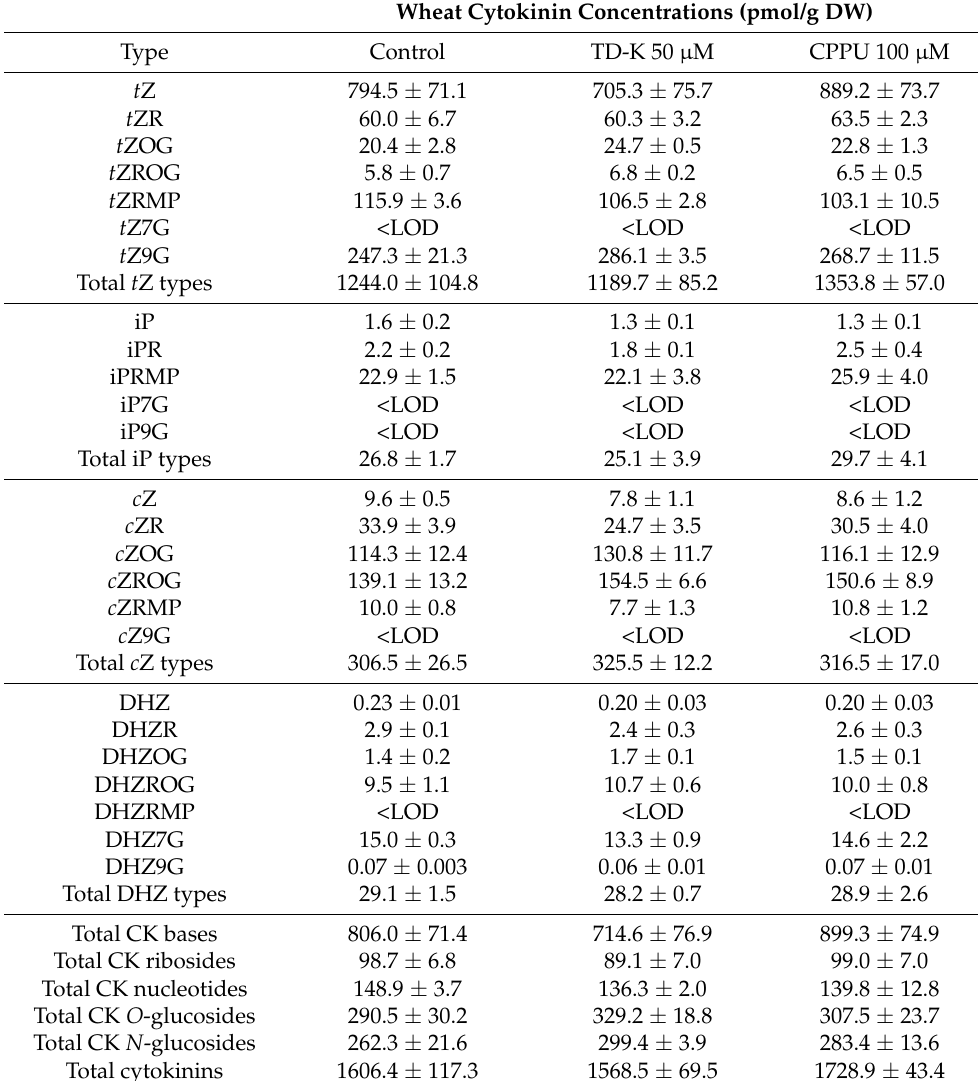
Table 2. LC–MS/MS analyses of the quantity of cytokinins in wheat (cultivar Torch, 2014/15) grains treated at anthesis with TD-K or CPPU. Measurements were made at four days after